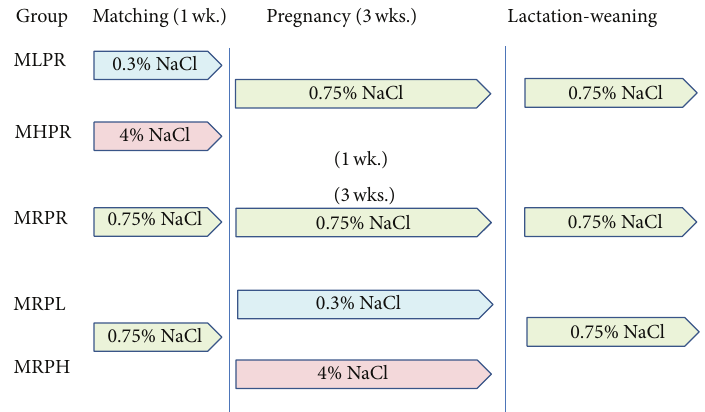
Figure 1: Protocol of the study. This graph shows each type of salt diet and the time period in which it was fed to the Dahl S rats. 0.3% NaCl, a low-salt (0.3% NaCl, w/w) diet; 0.75% NaCl, regular (0.75% NaCl, w/w) diet; and 4% NaCl, a high-salt (4% NaCl, w/w) diet.